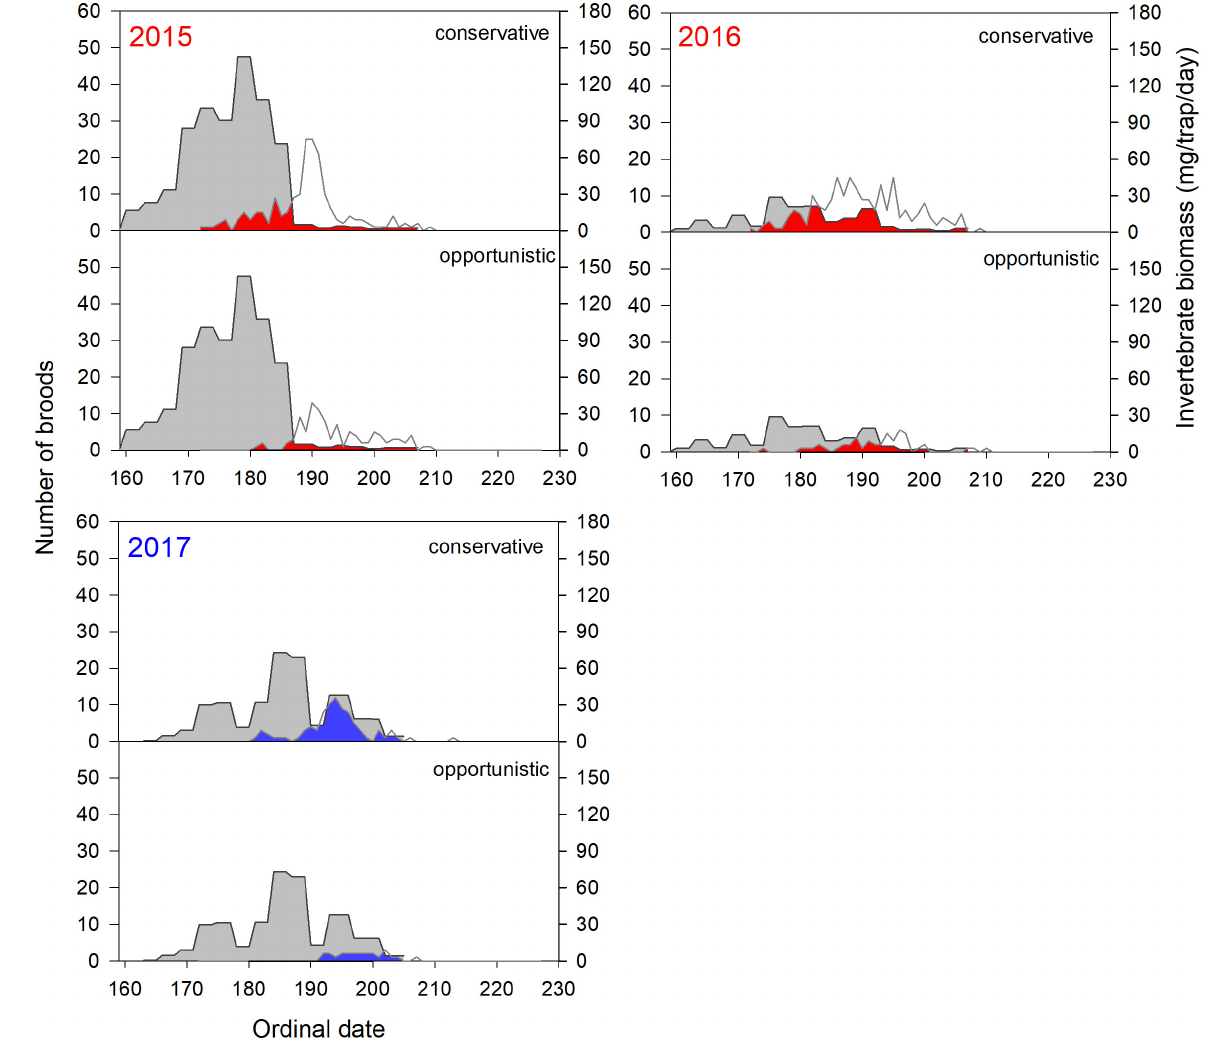
FIGURE 8 | Daily invertebrate biomass (gray) in relation to the number of conservative and opportunistic shorebird broods at peak energetic demand (i.e., 6 days post-hatch) in 2015–2017 at Colville River. The area of overlap between the two curves (red in early springs 2015 and 2016; blue in late spring 2017) illustrates the temporal degree of phenological match. The area outlined in white above red and blue areas reflects additional broods that were 6 days old. In most years, invertebrate sampling ended prior to the end of the brood rearing season (ordinal date 207, 207, and 205 in 2015–2017, respectively); therefore, phenological match cannot be assessed for broods after these time periods. See Table 2 for species assignments to reproductive strategies and sample